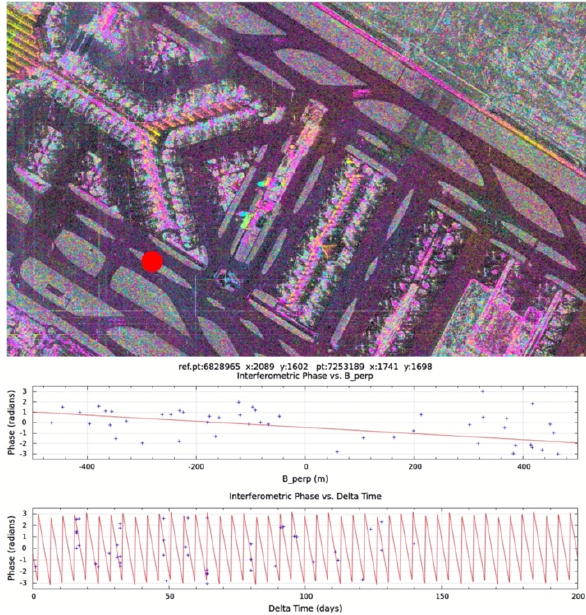
Figure 6 . Regression analysis for a pair of points.